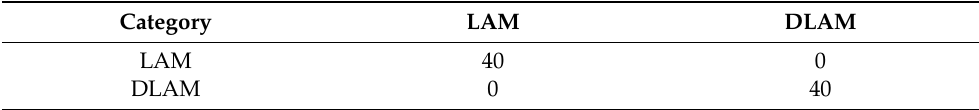
Table 6. Confusion matrix for decision tree with simulated data.